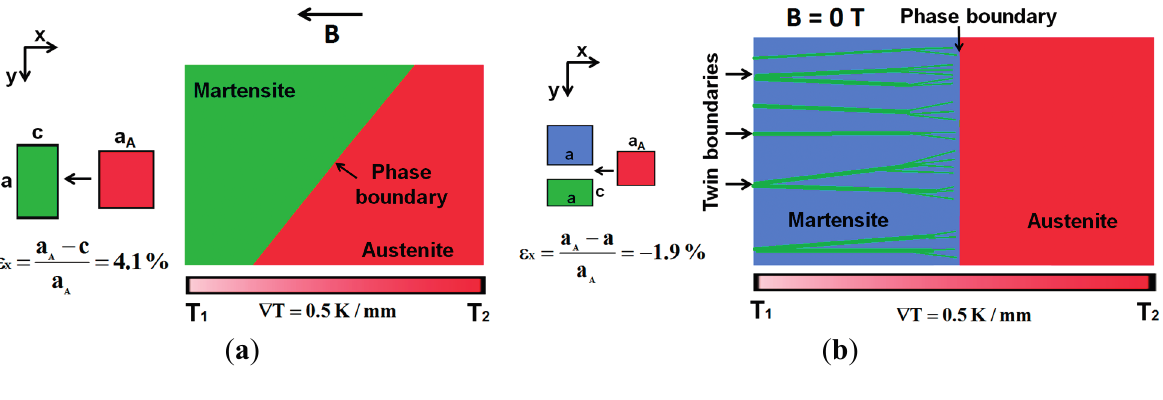
Figure 8. Schematic of single phase boundary actuation. A temperature gradient is generated along the x -direction, e.g., by local heating of the substrate. ( a ) In addition, a magnetic field is applied along the x -direction. ( b ) Reversible single phase boundary actuation for zero magnetic field. Reprinted with permission from [34], copyright 2014